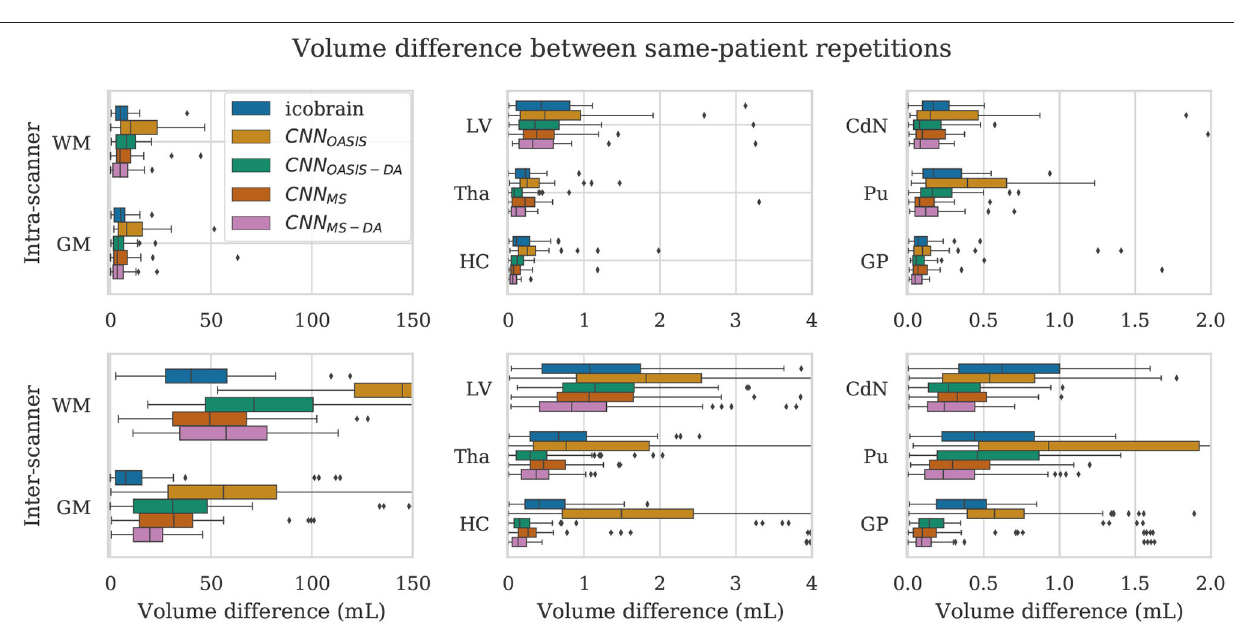
FIGURE 8 | Volume difference between intra-scanner and inter-scanner repetitions from the same patient. To be able to keep the same scale for intra-scanner and inter-scanner the CNN OASIS results are sometimes not fully